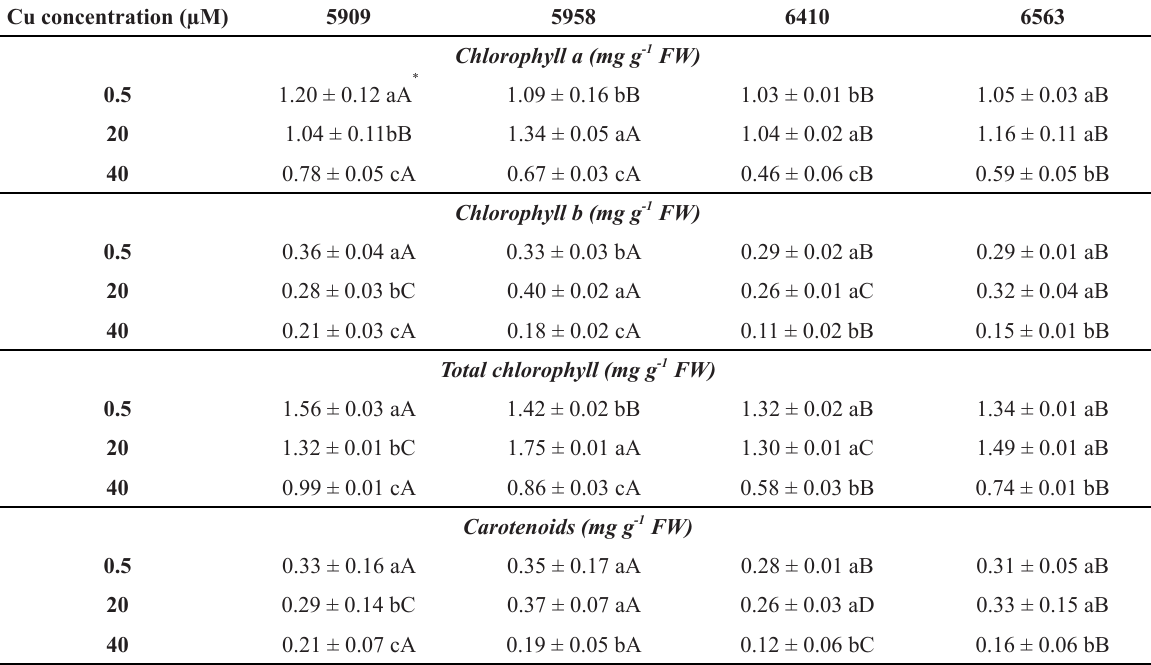
Chlorophyll and carotenoid concentration in the leaves of the four soybean cultivars (5909, 5958, 6410 and 6563) grown in nutrient solution at Cu concentrations: 0.5, 20 and 40 µM.